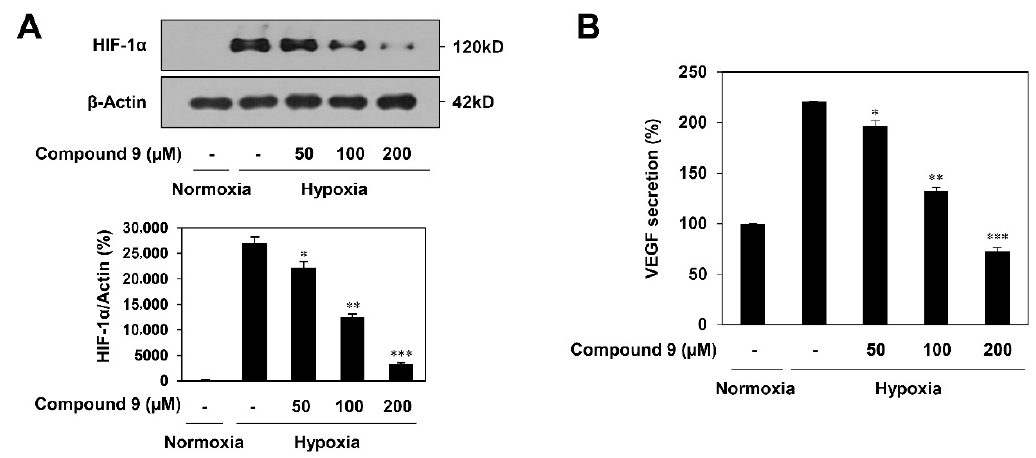
Figure 6. The HIF-1 α inhibitory e ff ect of compound 9 . ( A , B ) AGS gastric cancer cells were pretreated with compound 9 (50–200 µ M) for 1 h and then exposed to 1% O 2 for 11 h. ( A ) The e ff ect of compound 9 on HIF-1 α protein accumulation. Protein levels were detected by Western blot analysis and further quantified by densitometry. The level of β -actin was used as an internal control. ( B ) The e ff ect of compound 9 on VEGF expression. The concentration of VEGF protein in the supernatant was determined by a VEGF ELISA. * p < 0.05, ** p < 0.01, *** p < 0.001 vs. the hypoxic control. Each value represents the mean ± SD from three independent experiments.